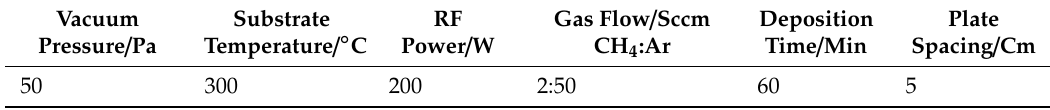
Table 1. The parameters in the deposition of nanographitic films (NGFs). RF: radio frequency.